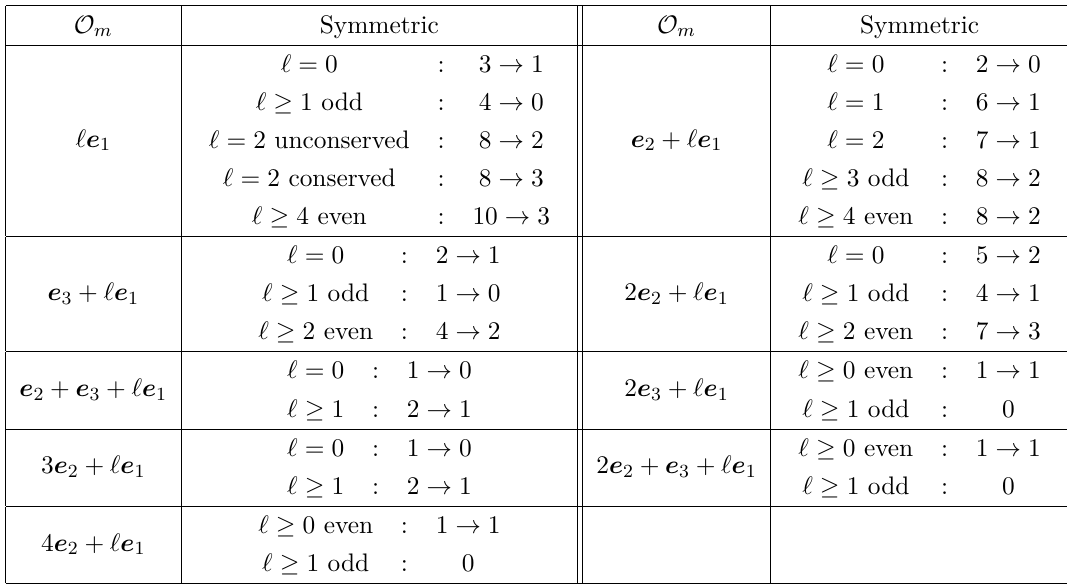
Table 2 . Number of independent tensor structures in three-point correlation